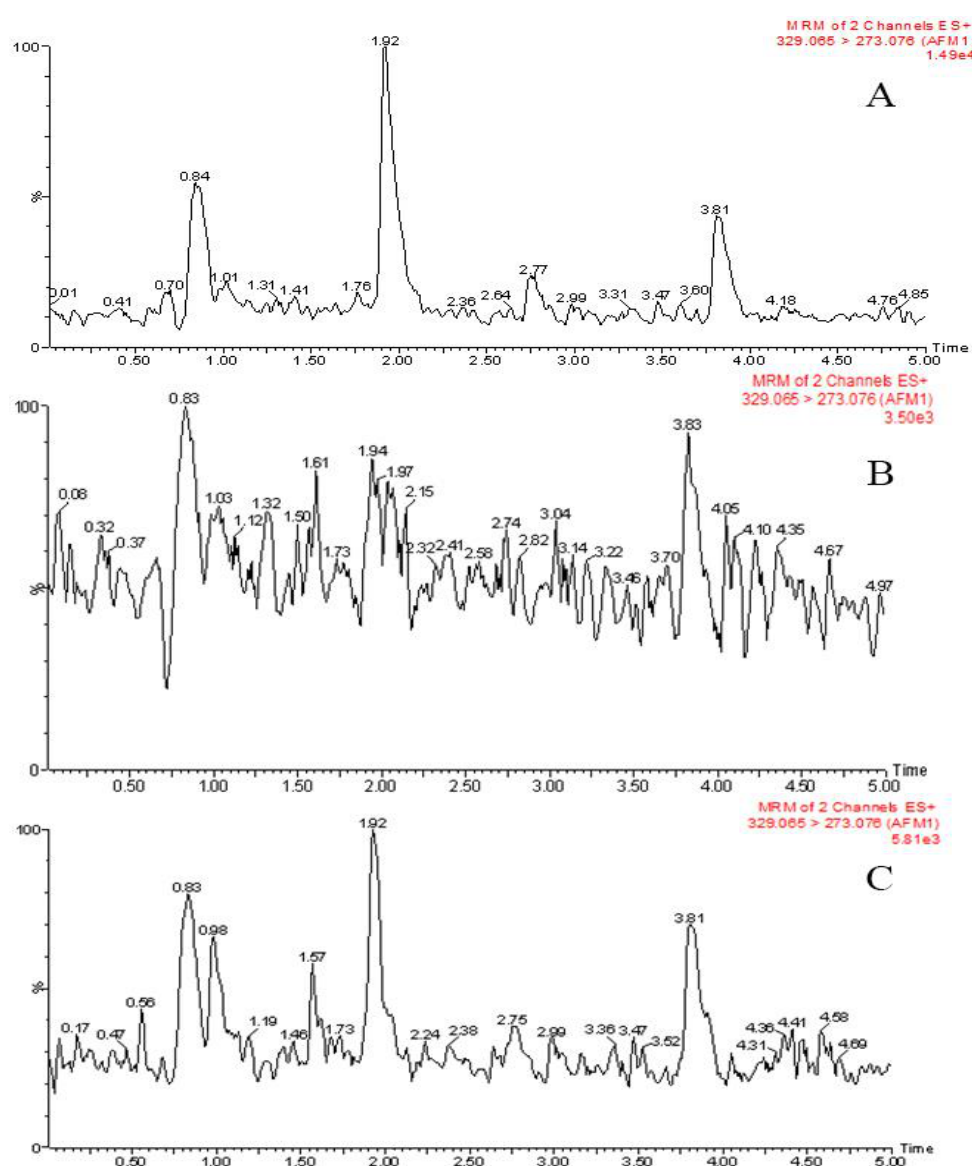
Figure 2. Extracted ion chromatograms of the blank matrix were treated in three different ways as described in Section 2.5 (( A ): acidification and salting out, ( B ): egg white gel, ( C ): immunoaffinity column).